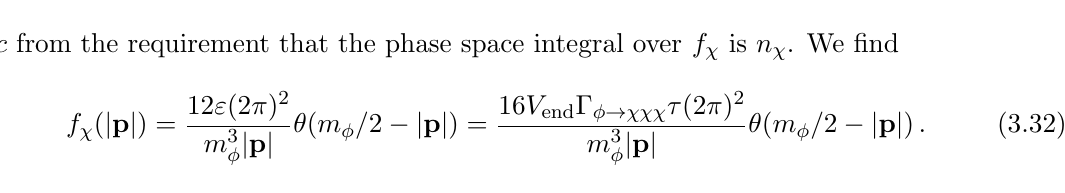
Figure 10. The same as (cid:12)gure 9, but with (cid:21) = 0 :